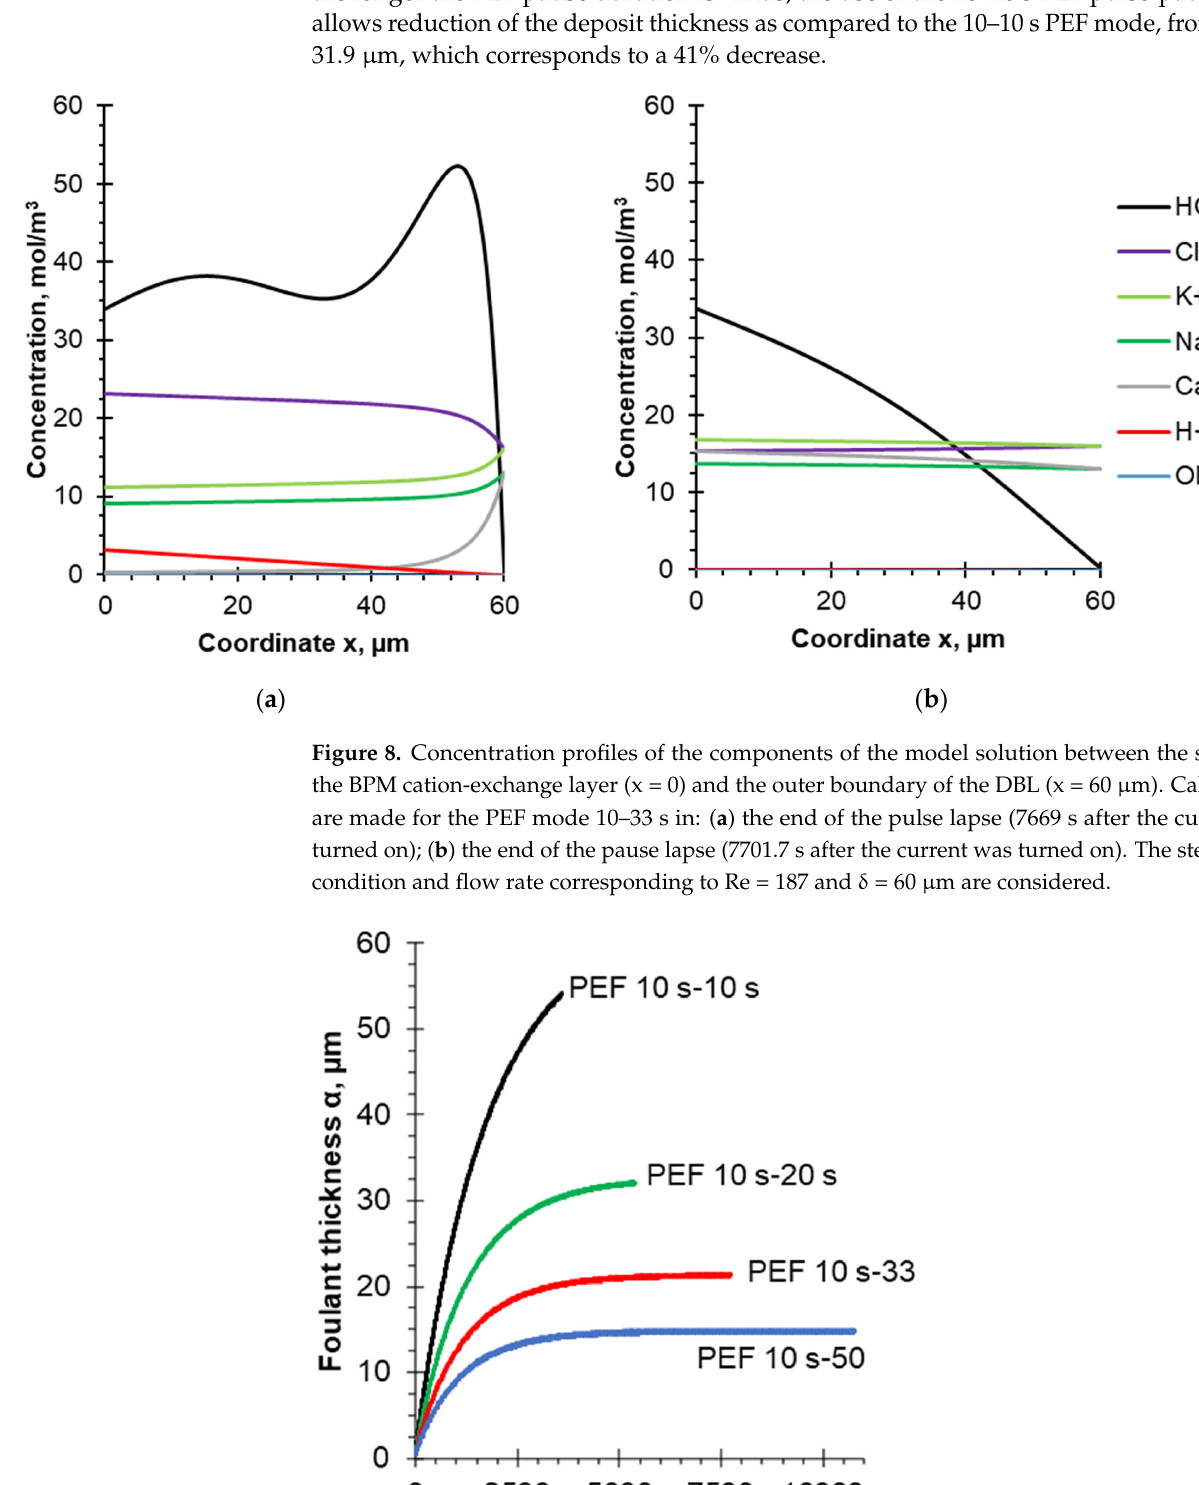
Figure 9. Time dependence of the protein deposit layer thickness at various current modes. Calculations are made for the steady-state condition and flow rate corresponding to Re = 374 and δ = 40 µm.